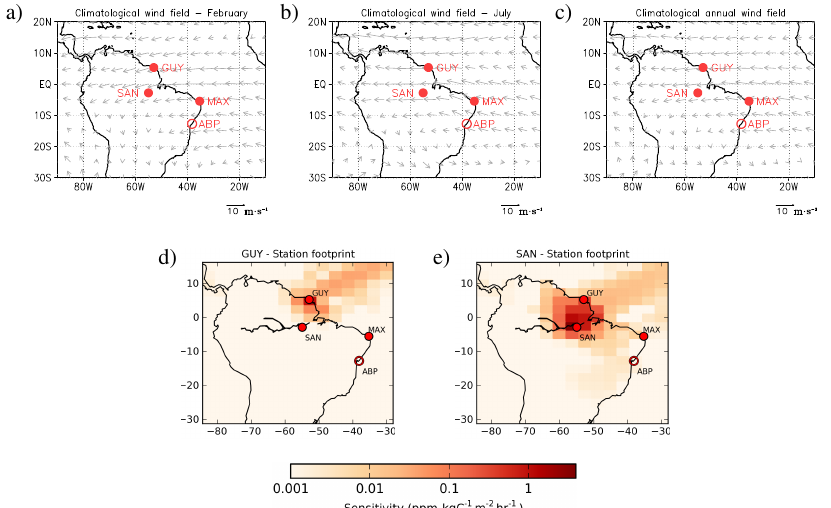
Figure 3. Top: location of assimilated surface stations in South America and climatological wind speed/direction for February (a) , July (b) and annual mean (c) , averaged over 1981–2010 between the surface and a level of 600hPa (source: NCEP/NCAR reanalysis). Sensi- tivity of surface atmospheric CO 2 mole fractions measured on 20 February 2009 at 10:00UTC, at Guyaflux (07:00LT) (d) and Santarém (06:00LT) (e) , to a constant increment of surface fluxes during the 2 days prior to the measurement. Sensitivity values are expressed in log scale. Open circles: sites with discrete air samplings. Filled circles are measurements taken with continuous